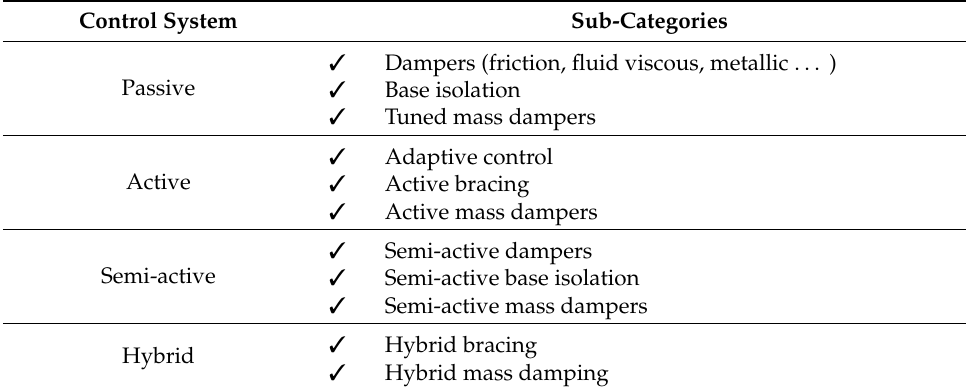
Table 1. The existing structural energy dissipation